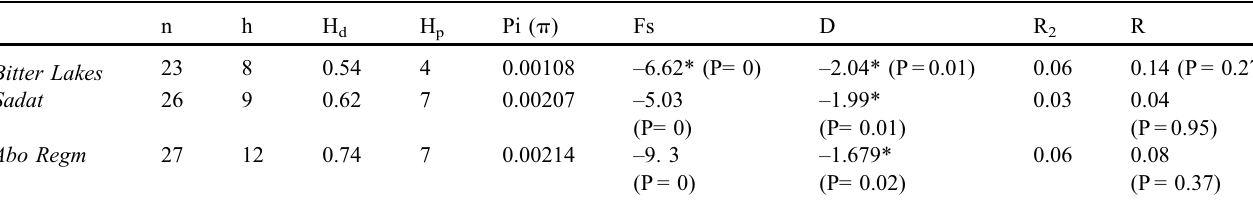
Table 2. Different haplotype diversity, nucleotide diversity, neutrality, and raggedness analyses values for Egyptian P. semisulcatus sampled from the Bitter Lakes and Gulf of Suez,